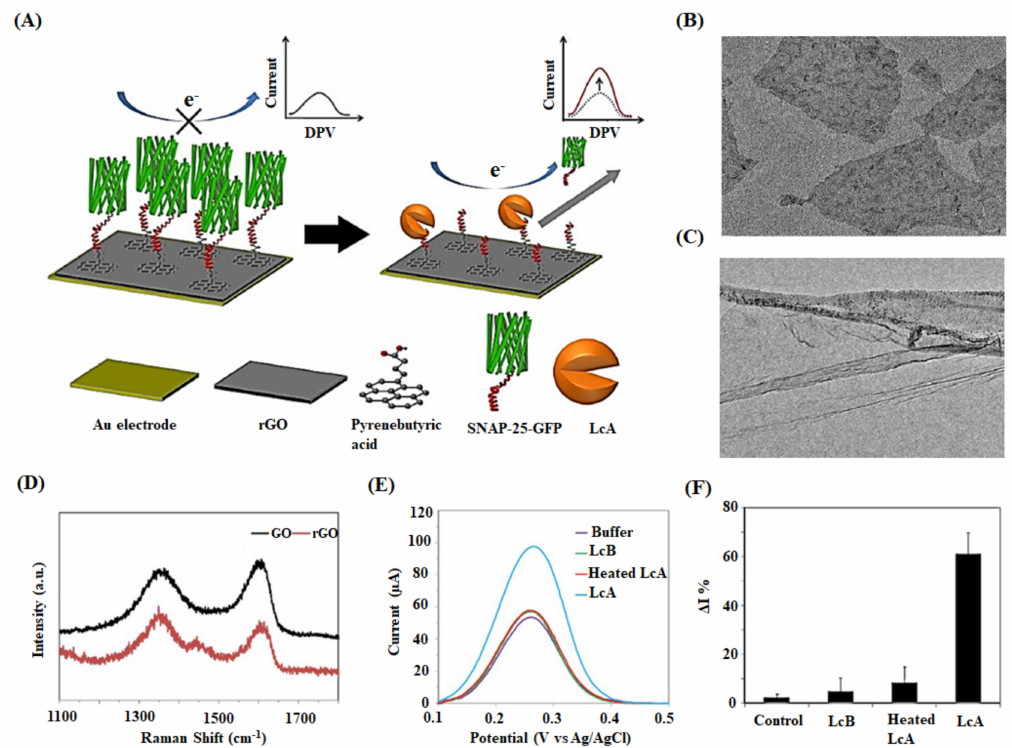
Figure 6. ( A ) Schematic diagram illustrating the detection mechanism of an rGO-based biosensor. SNAP-25-GFP peptide is immobilized on the rGO surface, which is previously conjugated with pyrenebutyric acid. The target BoNT-LcAs specifically cleave SNAP-25-GFP molecules, detaching them from rGO/Au electrode surface. The detection of enzymatic activity decreases the hindrance of redox probes transfer on electrodes resulting in increased electrochemical currents. ( B ) TEM image of rGO flakes and ( C ) rGO sheets with ripples and wrinkles. ( D ) Raman spectra of GO and rGO. ( E ) Specificity testing of control buffer and fresh BoNT-LcA, heated BoNT-LcA, and fresh BoNT-LcA at the concentration of 1 ng mL − 1 . ( F ) Relative DPV peak current change ( ∆ I%) for the same samples